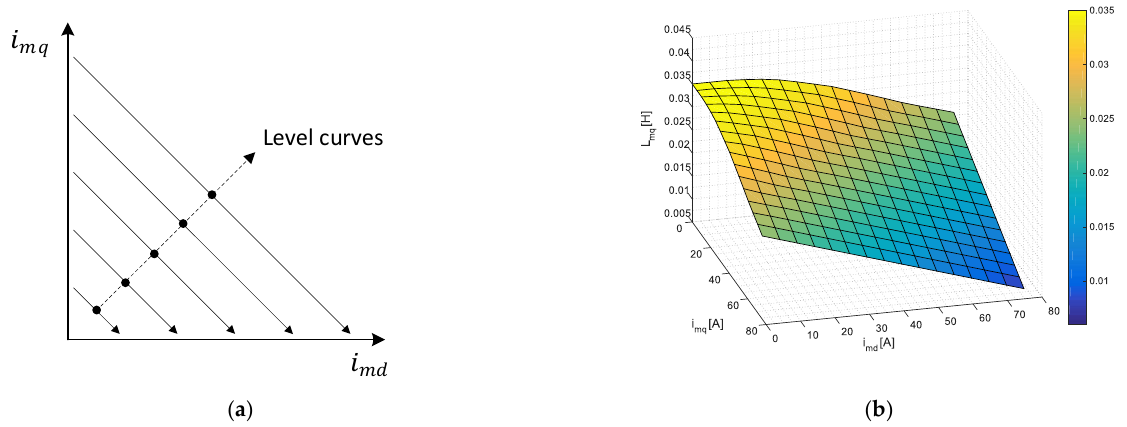
Figure 4. ( a ) Generation of the inductance function in the quadrature axis according to [12]; ( b ) Generated inductance functions in the quadrature axis.